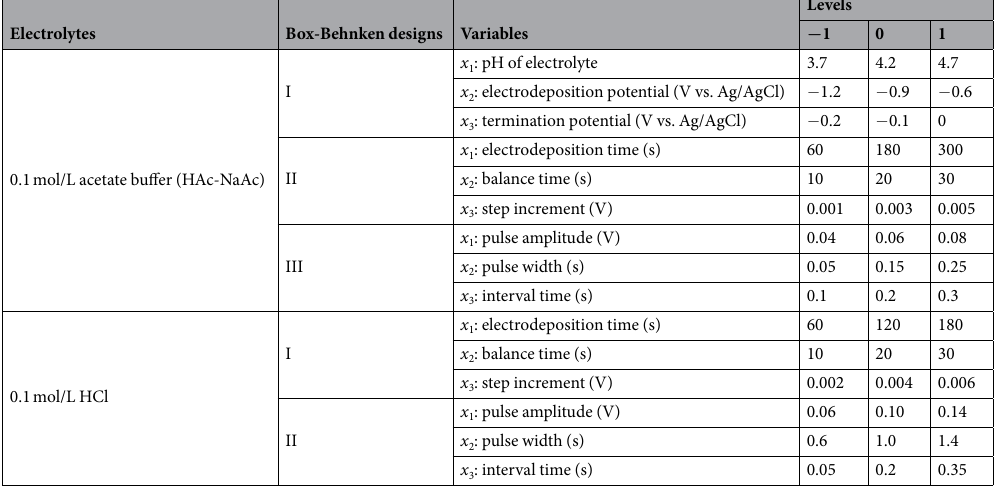
Table 4. Levels of variables selected for Box-Behnken